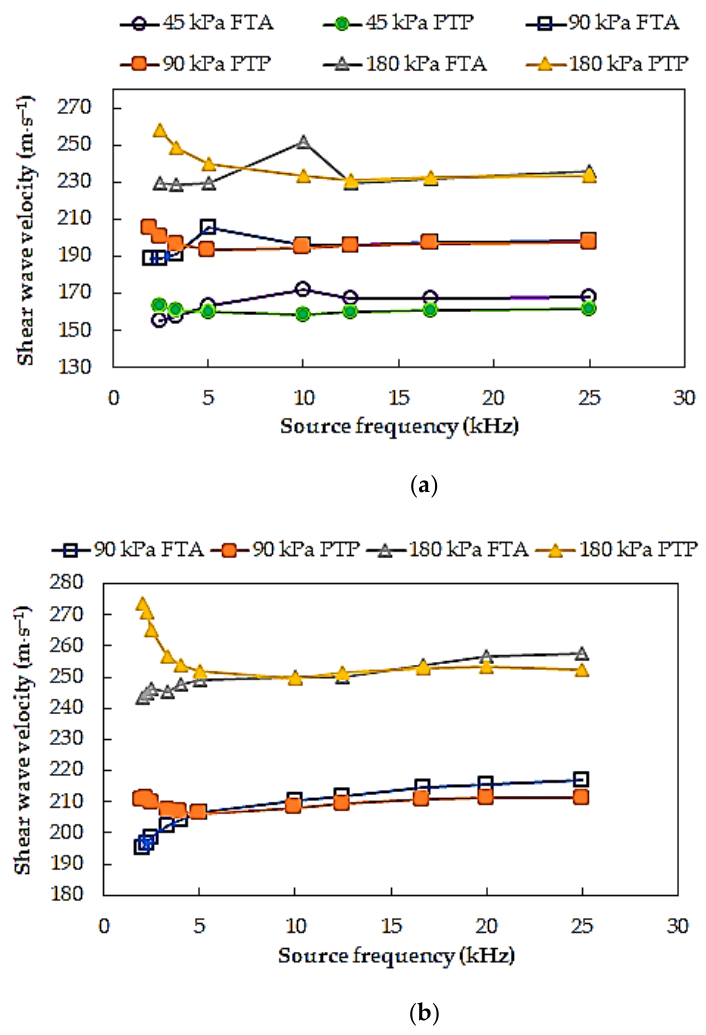
Figure 6. Shear wave velocities for different source frequencies and different mean effective stress, data for the test specimen: ( a ) S11, test series XI, steps 1, 2, 3, and ( b ) S12, test series XV, steps 1,2.